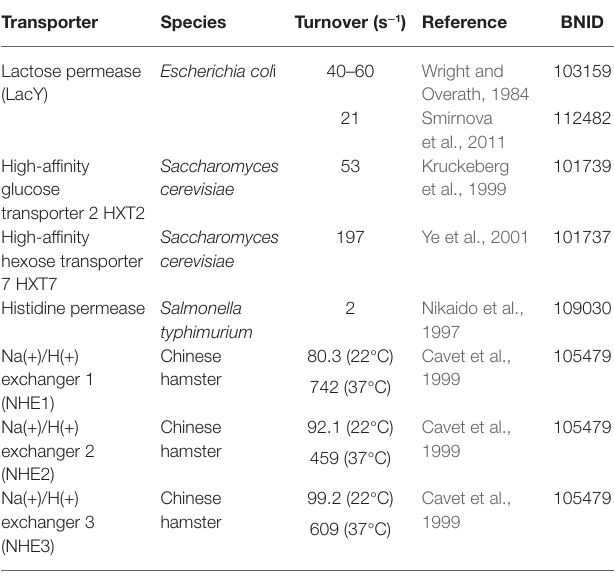
TABLE 2 | Substrate turnover rates of transporters from various